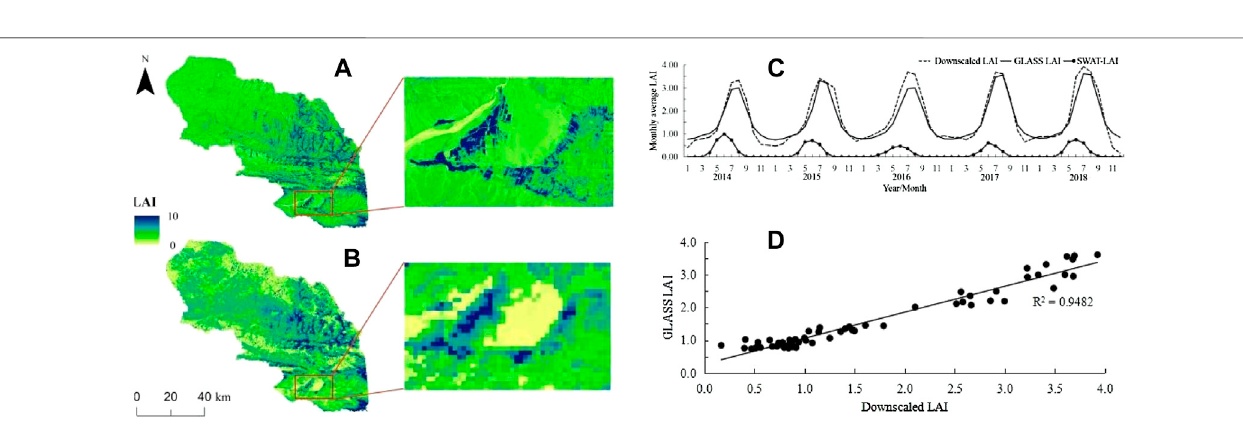
FIGURE 6 | Comparisons of the downscaled leaf area index (LAI) and the original Global LAnd Surface Satellite (GLASS) LAI. (A) Spatial distribution of the downscaledLAI. (B) SpatialdistributionoftheoriginalGLASSLAI. (C) MonthlyvariationofthedownscaledLAIandGLASSLAI. (D) Correlationbetweenthedownscaled LAI and GLASS